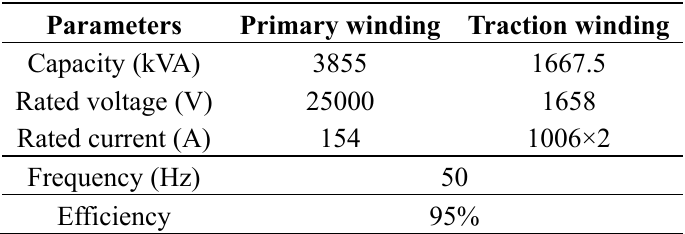
Table 2. Main traction transformer